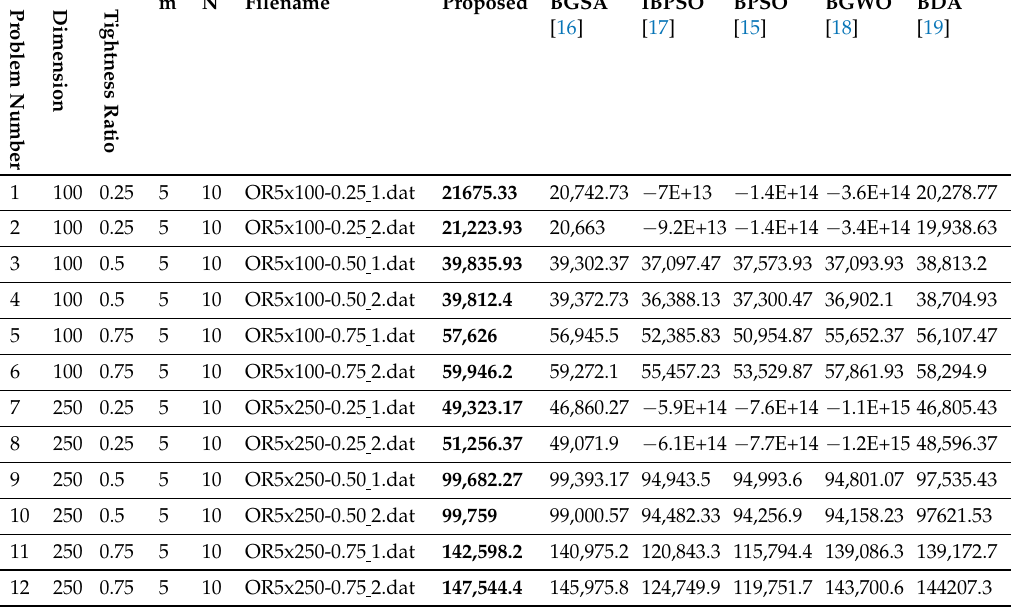
Table 3. Optimization results using various optimization algorithms for the maximization of the knapsack